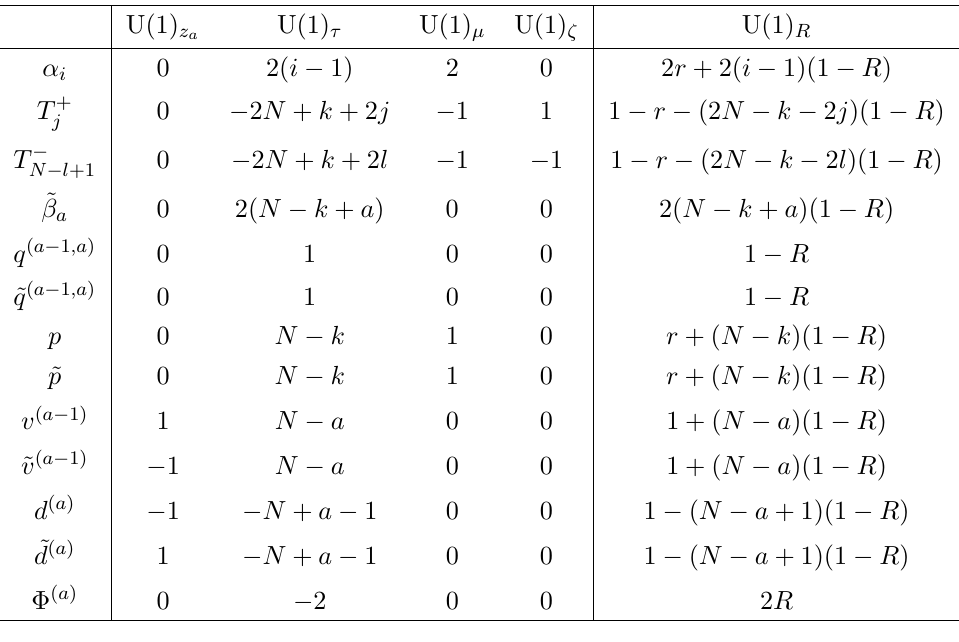
Table 4 . Representations and charges under the global symmetries of all the chiral (cid:12)elds of Theory B. In the table the indices i , j , l run from 1 to N (cid:0) k , while a from 1 to k (cid:0) 1. By